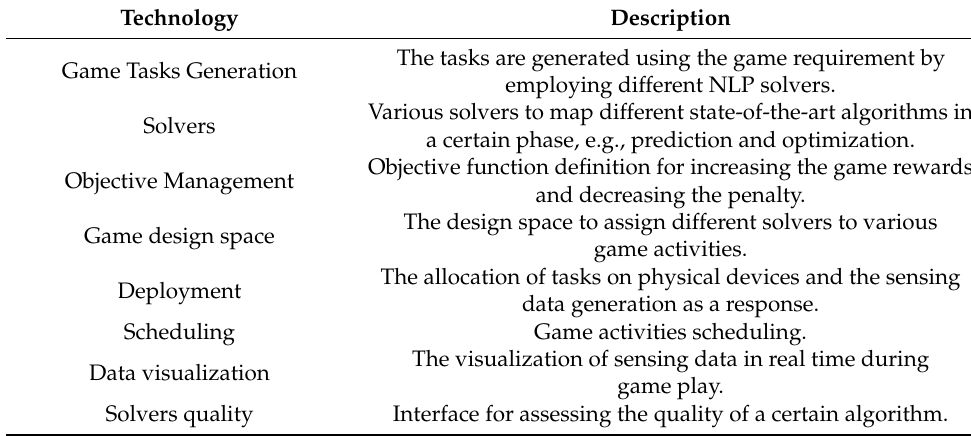
Table 4. Technology stack of the proposed architecture.